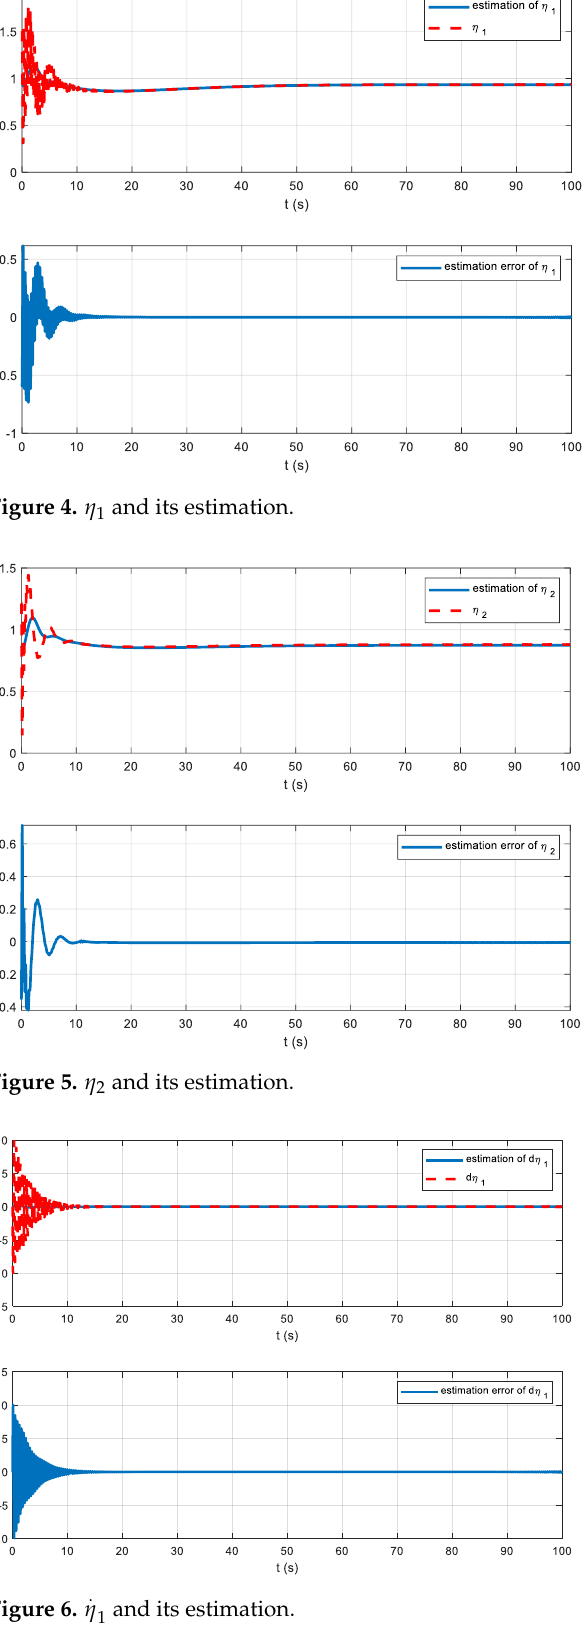
. Figure 6. η and its 1  and its estimation. Figure 6. 1